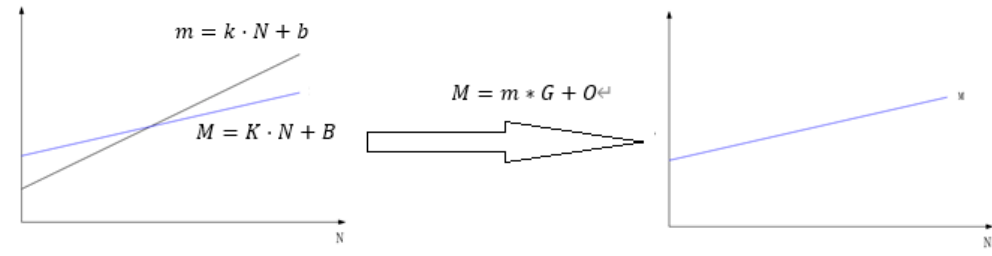
Figure 4. Correction process diagram of two-point method (x coordinate: incident light energy y coordinate: gray value).